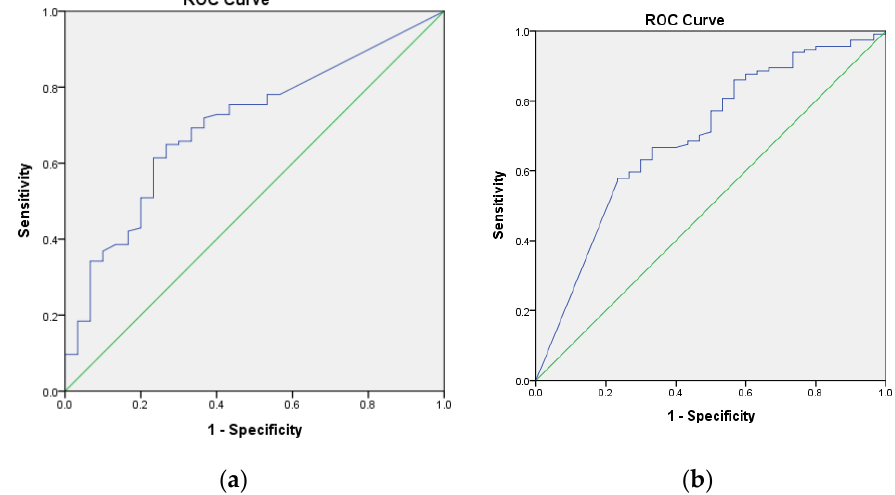
Figure 2. ( a ) The receiver operating characteristic (ROC) curve was used to determine a threshold level of the preoperative migration percentage (MP) above which the risk of unsatisfactory surgical result was significantly elevated. The inflection point of the curve corresponded to the preoperative MP of 61.8%; this represents the value with the highest sensitivity and specificity and was thus chosen as the preoperative MP. The area under the curve (AUC) is represented by the area of the graph beneath the blue line. ( b ) The ROC curve was used to determine a threshold level of the postoperative MP above which the risk of unsatisfactory surgical result was significantly elevated. The inflection point of the curve corresponded to the preoperative MP of 5.1%. The AUC is represented by the area of the graph beneath the blue line.